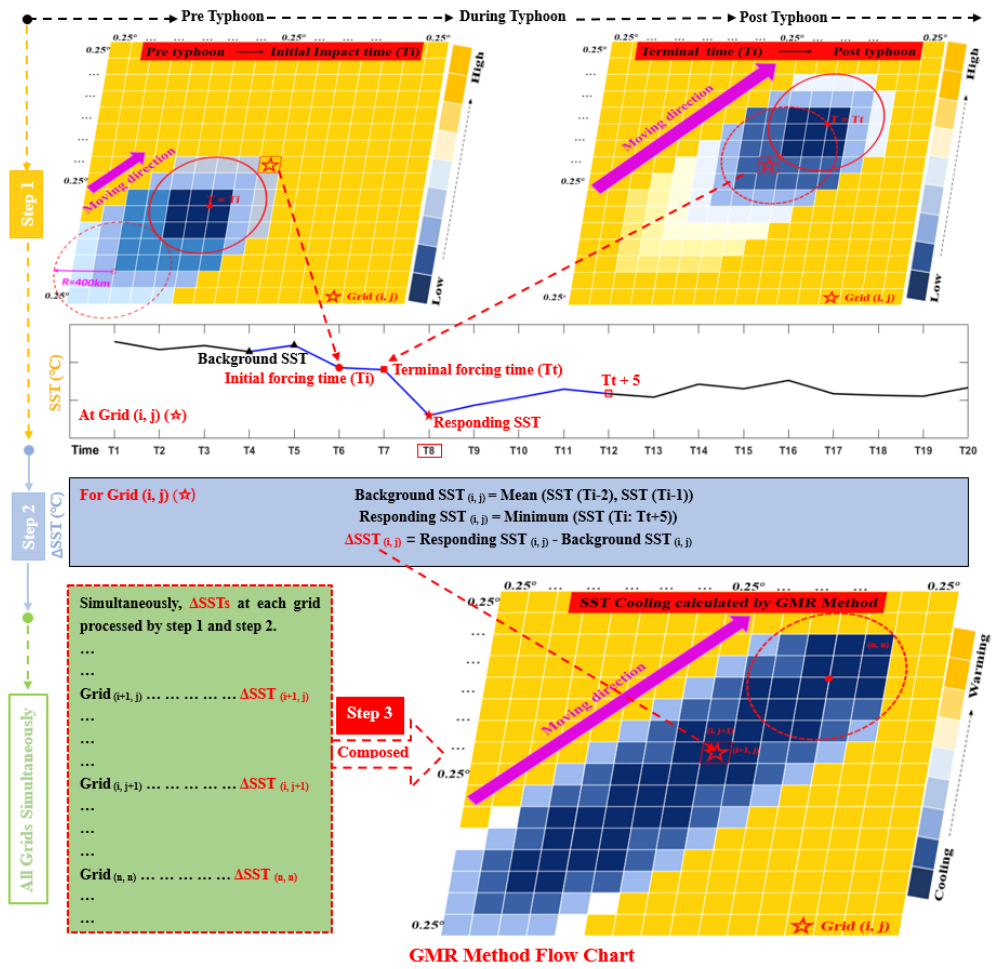
Figure 3. Schematic illustration of the GMR method for the calculation of SST cooling after the passage of a typhoon. The first step defines the region influenced by the typhoon track and records the initial and terminal impact times for the target grid. The second step calculates the maximum response for this grid. The third step calculates the maximum response of all grids composed to the last SST cooling field by the GMR method.